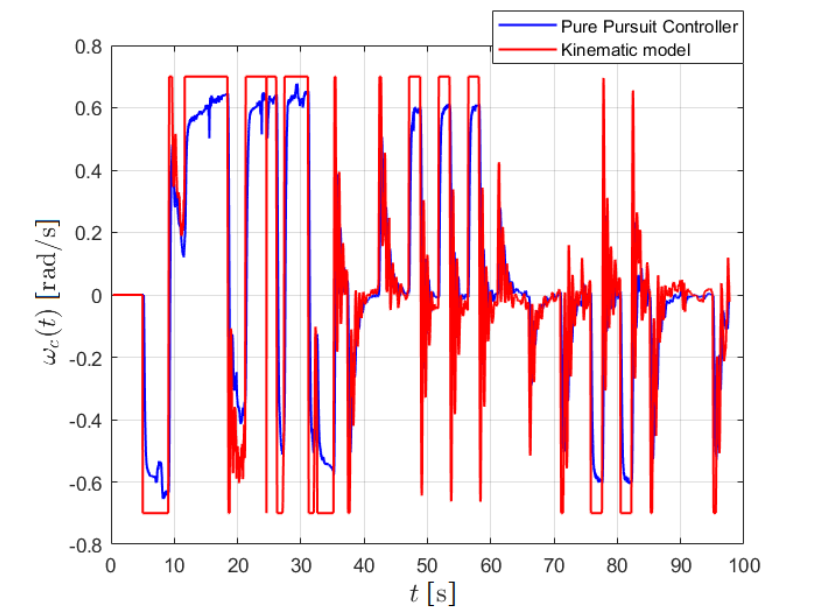
Figure 35. Angular velocity ω c ( t ) of the QBot 2e robot.